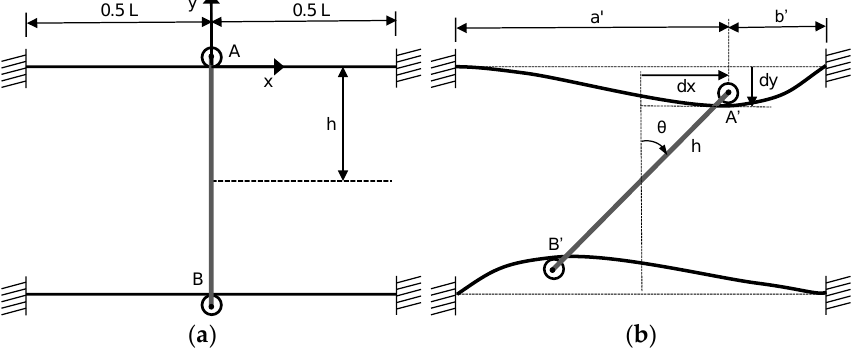
Figure 5. ( a ) Unloaded and ( b ) loaded snapshots of the NES shims. Table 1. Material and geometrical properties of the NES shims. Parameter Value